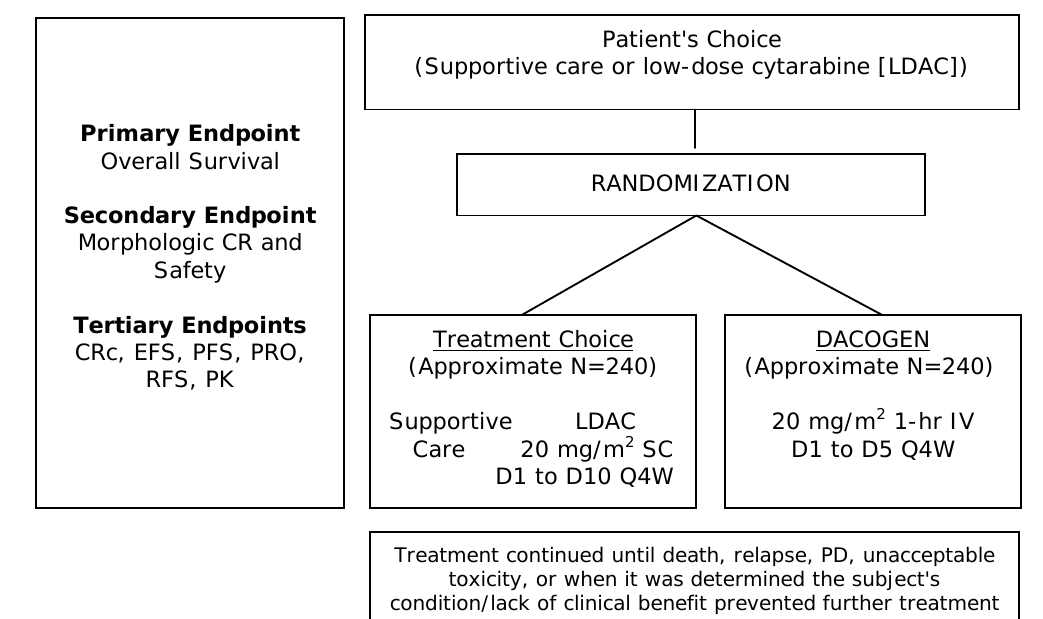
Figure 2: Study DACO-016